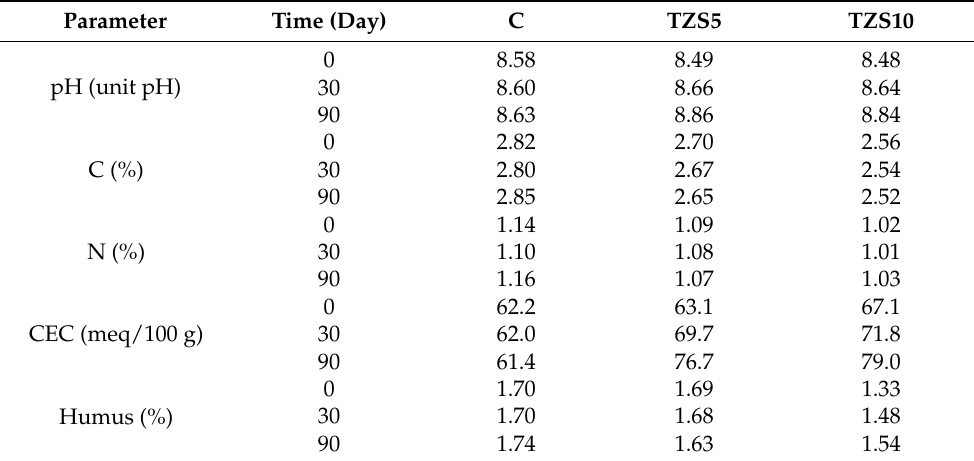
Table 2. Physico-chemical parameters of the control soil (C), 5% (TZS5), and 10% (TZS10) zeolite- amended soil at 0, 30, and 90 days.